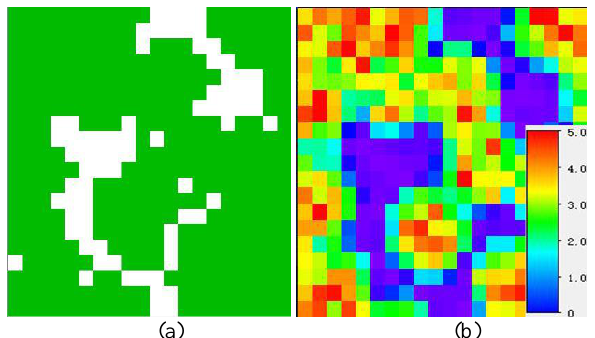
Figure 4. (a) Tree crown mask. (b) SIF image at 740nm